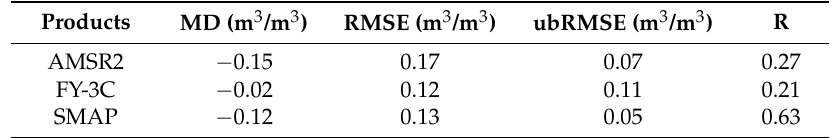
Figure 5. Temporal variations in the soil moisture data from the CASMOS stations and the FY-3C, AMSR2, and SMAP satellite products, and the rainfall data around the O2342 station during 2016. The gray line is the soil moisture (SM) daily mean from the CASMOS. The magenta, green, and cyan lines respectively represent the SM daily mean of the FY-3C, AMSR2, and SMAP products, and the blue histogram represents the daily precipitation. Table 4. Statistical parameters for FY-3C, AMSR2, and SMAP against the CASMOS measurements of the O2342 station during 2016. Only the dates when the compared datasets both have observations were used.